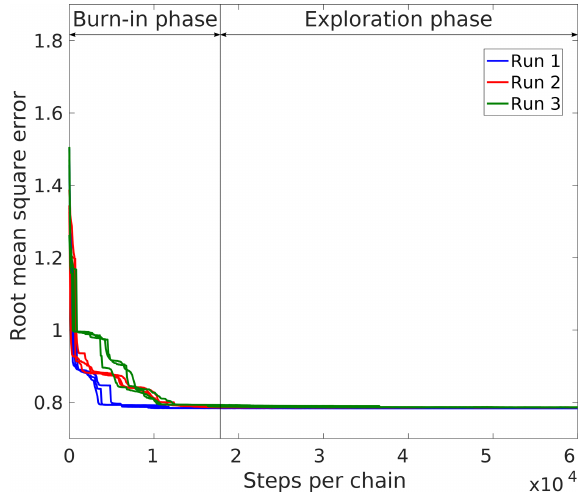
Figure 4. RMSE weighted by the standard deviation of the data error for the three inversion runs of the observed VSP data shown in Fig. 3. As the estimate of the standard deviation of the data er- ror is fixed at a high value, the RMSE drops below 1. The vertical black line indicates the separation of the burn-in and the exploration phases, associated with the MCMC search of the parameter